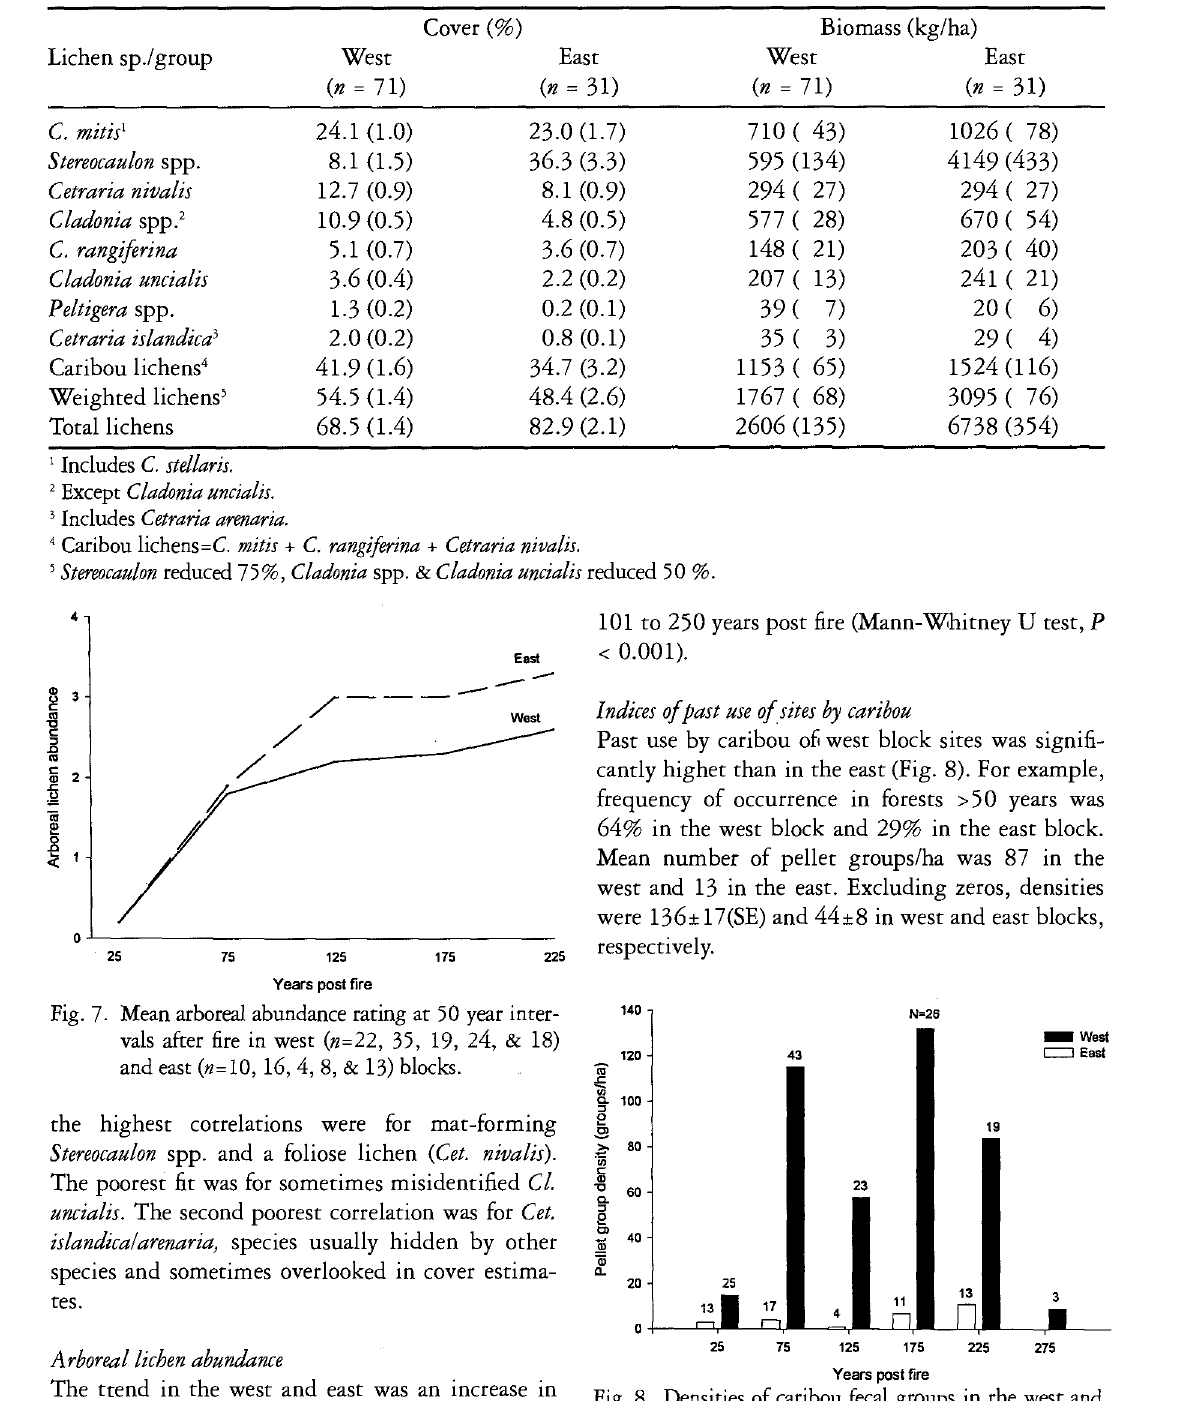
Fig. 8. Densities of caribou fecal groups in rhe west and east blocks in 50-year intervals after fire on the winter range of the Beverly herd in northern